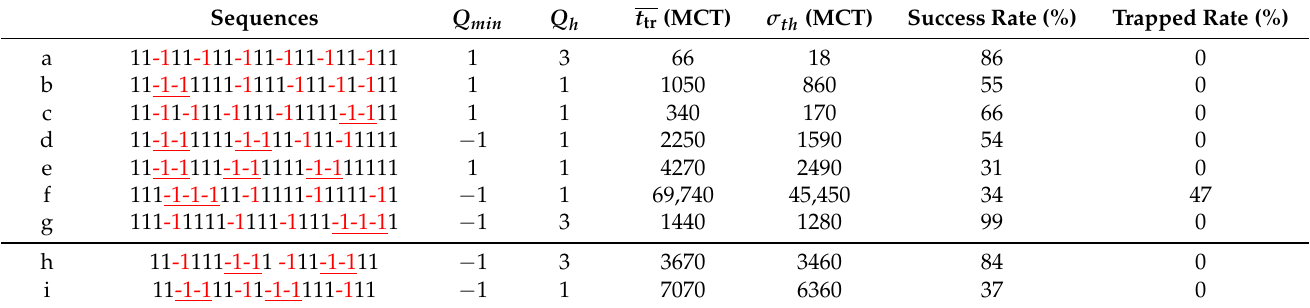
Table 3. Comparison of translocation times of specific sequences with Q = 8 and N = 20 (a–g) and sequences of IDP IN (h,i) with Q = 4 and N = 16, engaging in the cis -to- trans direction under + 150 mV of electric potential. (Favorable and antagonistic charges are labeled as 1 and − 1, respectively.) Antagonistic charges are highlighted as red. The statistics were obtained with t w = 1.6 × 10 5 from 10,000 different translocation trials for each sequence. (a) Regular sequence, (b) 1 block of (-1-1), (c) reverse sequence of (b), (d) 2 blocks of (-1-1), (e) 3 blocks of (-1-1), (f) 1 block of (-1-1-1), (g) reverse